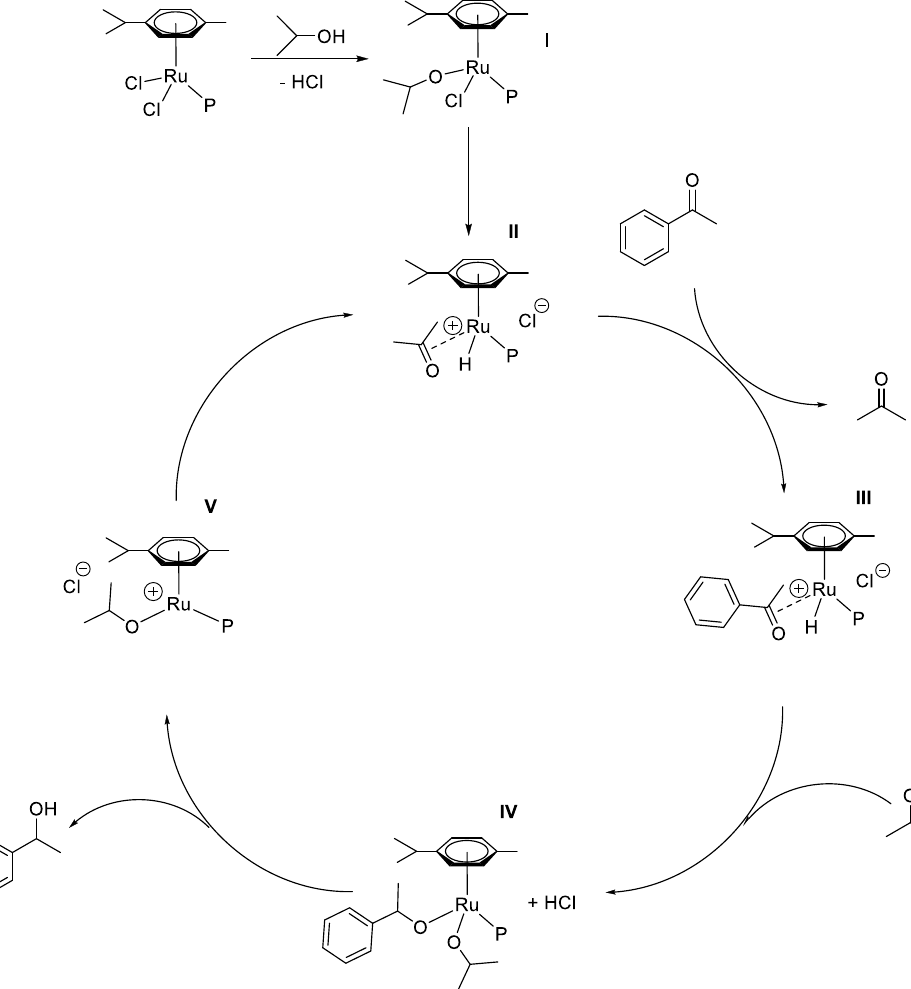
Scheme 8. Proposed inner sphere dissociative catalytic cycle for transfer hydrogenation mediated